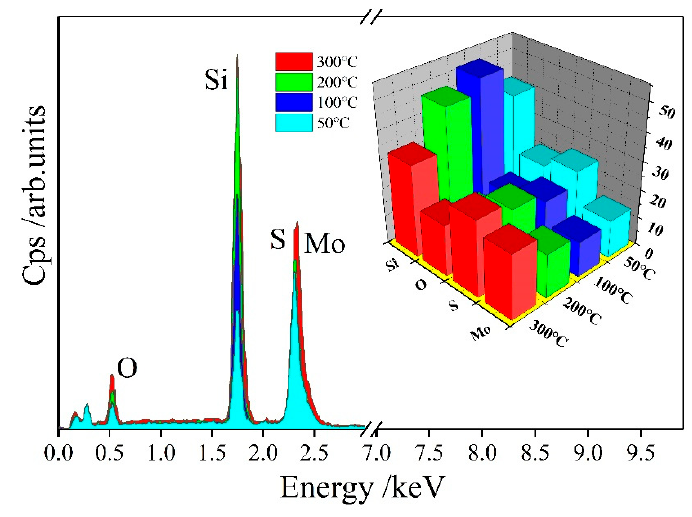
Figure 3. Energy-dispersive spectrometer (EDS) spectra of the MoS 2 films prepared at different deposition temperatures.